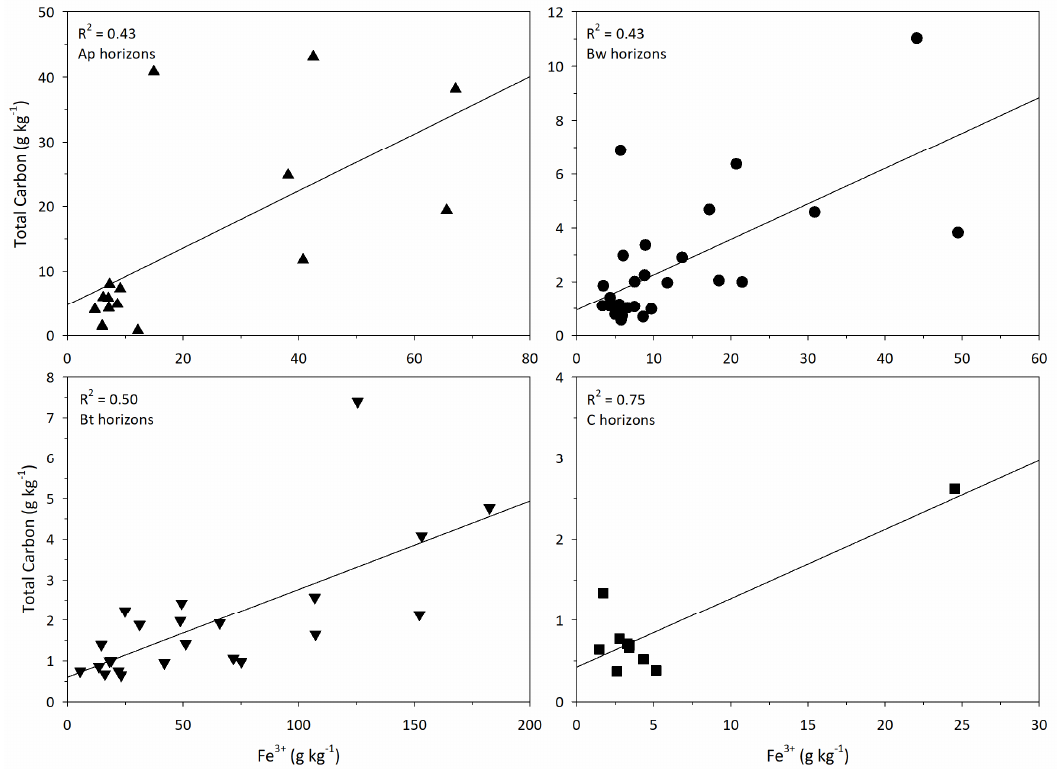
Figure 8. Total carbon and total Fe 3+ (CDB extractable) in the particle-size fractions of three sandy Alfisols under different land use. Note different x- and y-axes scales.